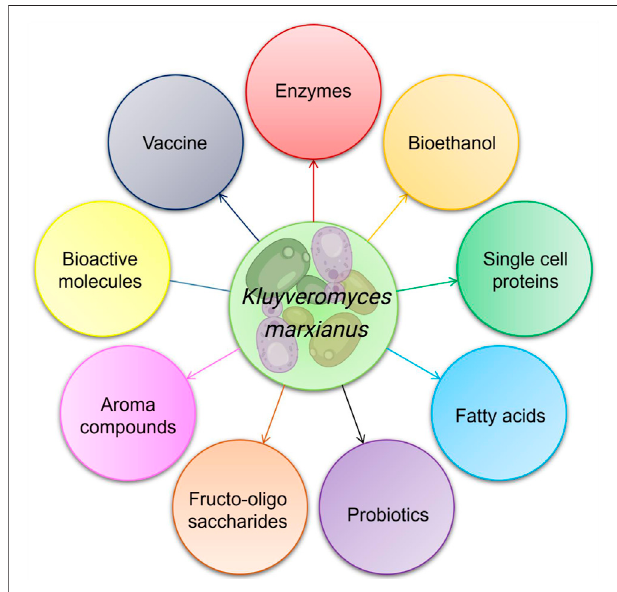
FIGURE 1 | Array of value-added functional bioproducts obtained from Kluyveromyces marxianus